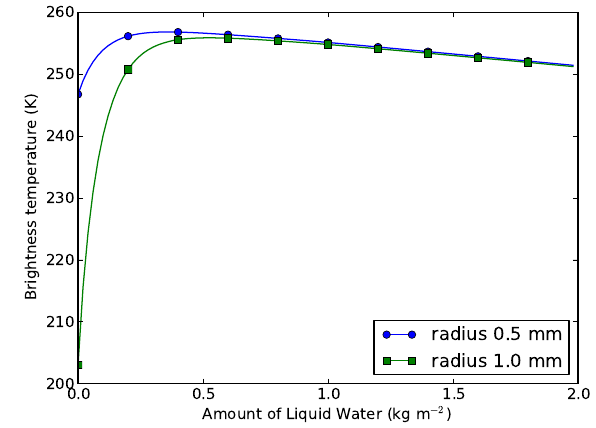
Fig. 9. Brightness temperature at 19GHz and horizontal polariza- tion as a function of the total amount of liquid water in the snow- pack. The temperature is 273K, density is 300kgm − 3 and there exist two grain size values (0.5 and 1mm). The liquid water is con- centrated in the top first 10cm of the